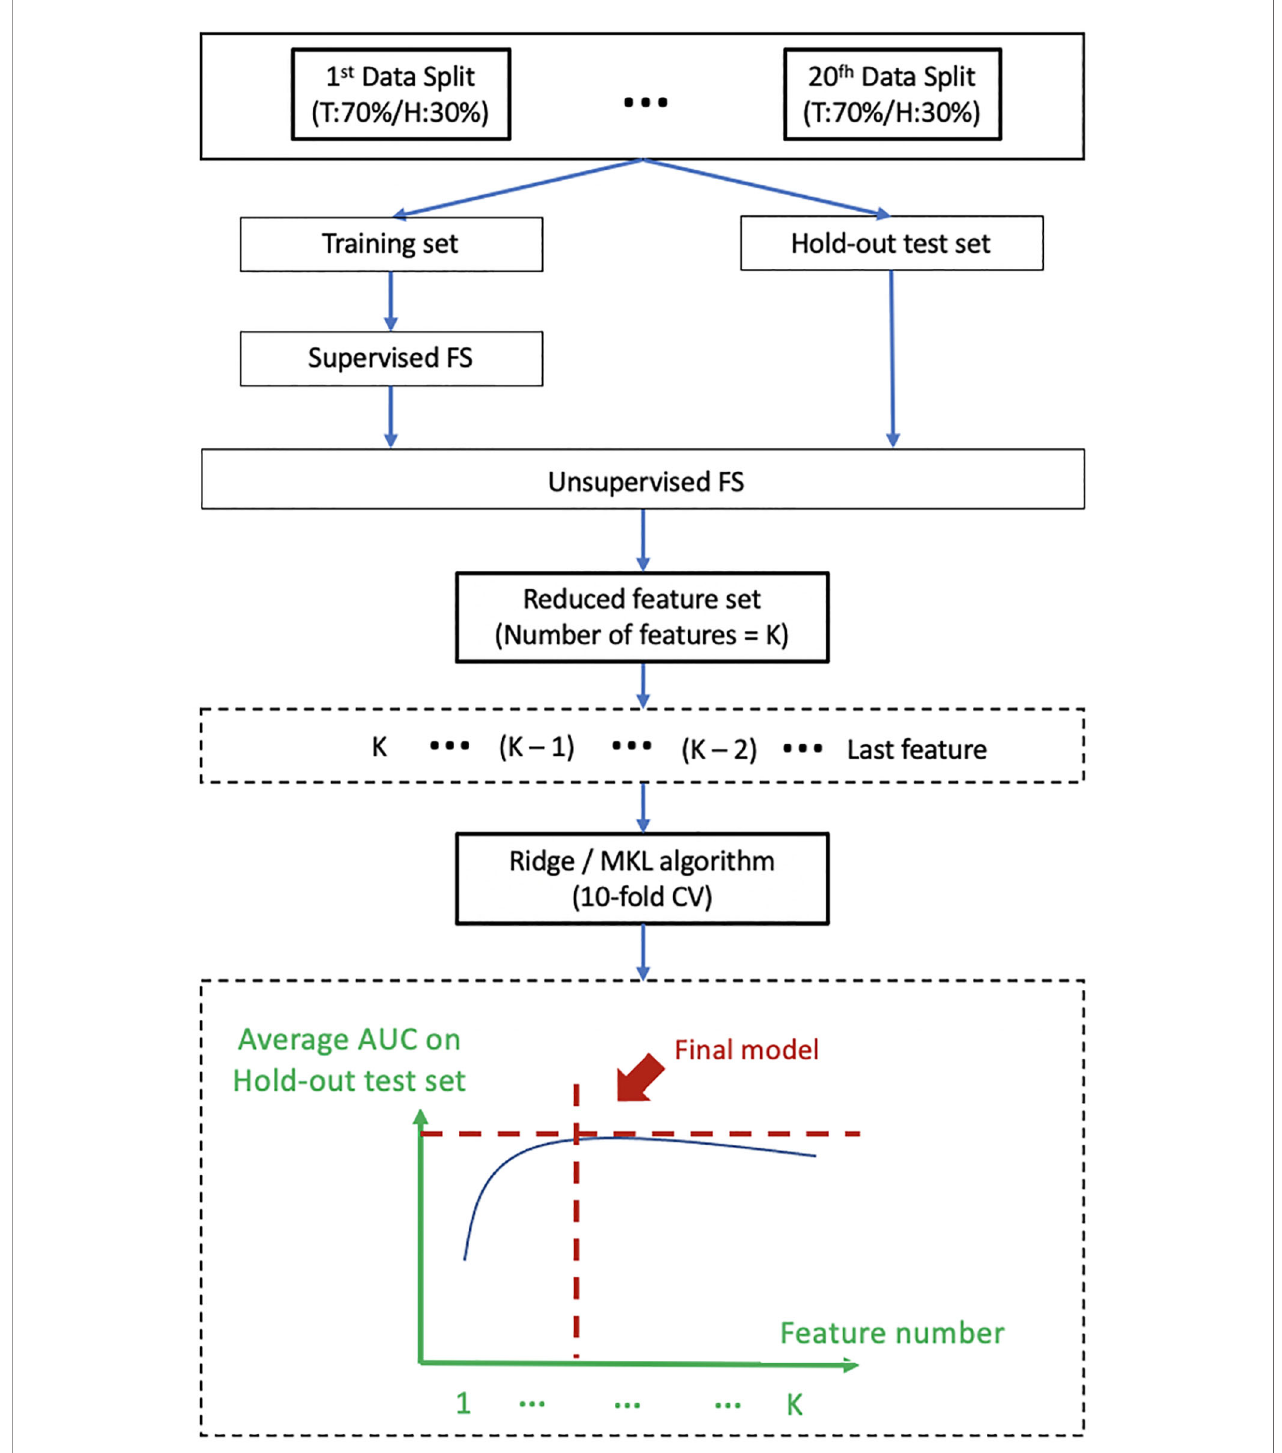
FIGURE 2 | Shows a schematic diagram for model development. T, Training set; H, Hold-out test set; FS, feature selection; MKL, Multi-Kernel Learning; CV, Cross- Validation; AUC, Area Under the Receiver Operating Characteristics